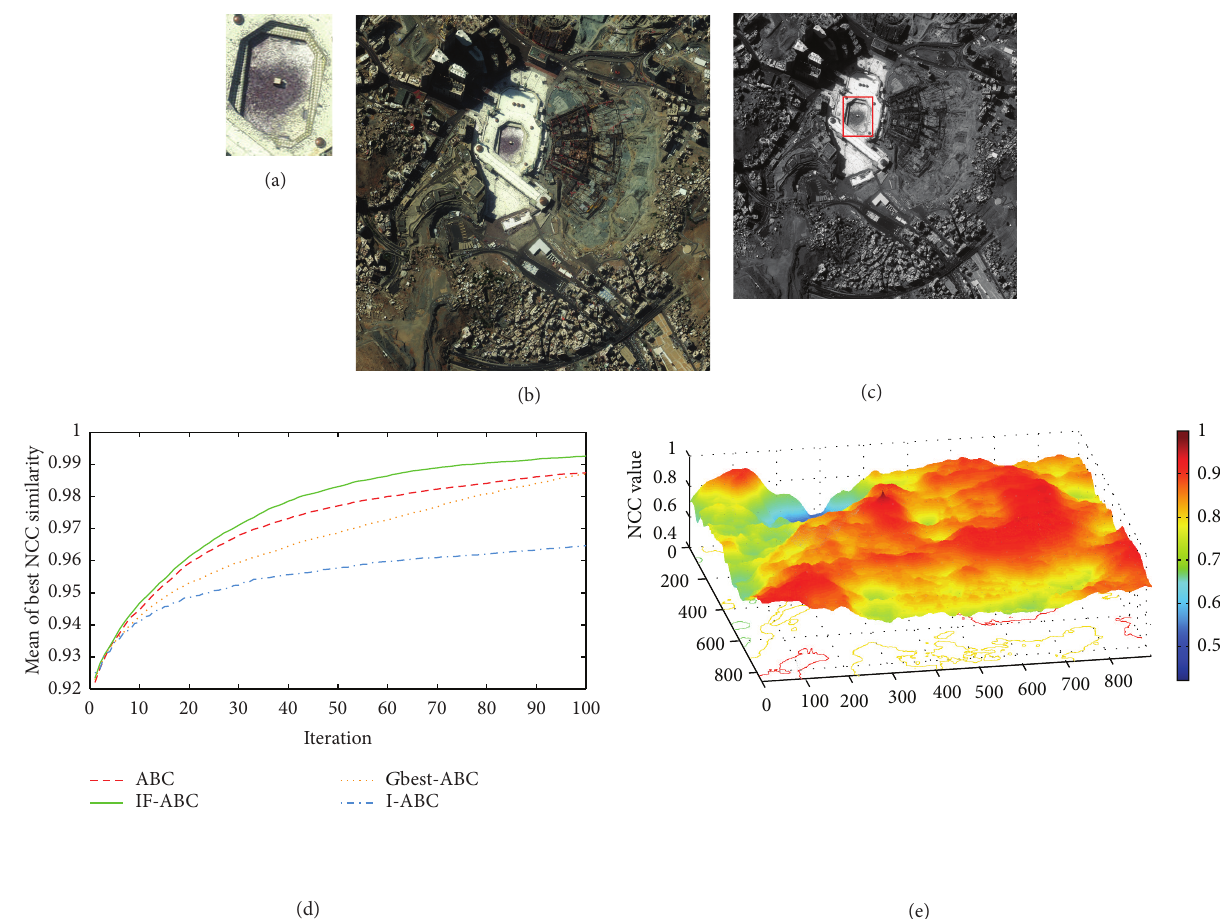
Figure 3: Ideal template matching case 1: satellite imagery of Holy City in Mecca. (a) Predefined template image (107 × 142); (b) source image (1000 × 1002); (c) ground matching truth; (d) comparative evolution curves of four ABC algorithms; (e) surface illustration of searching